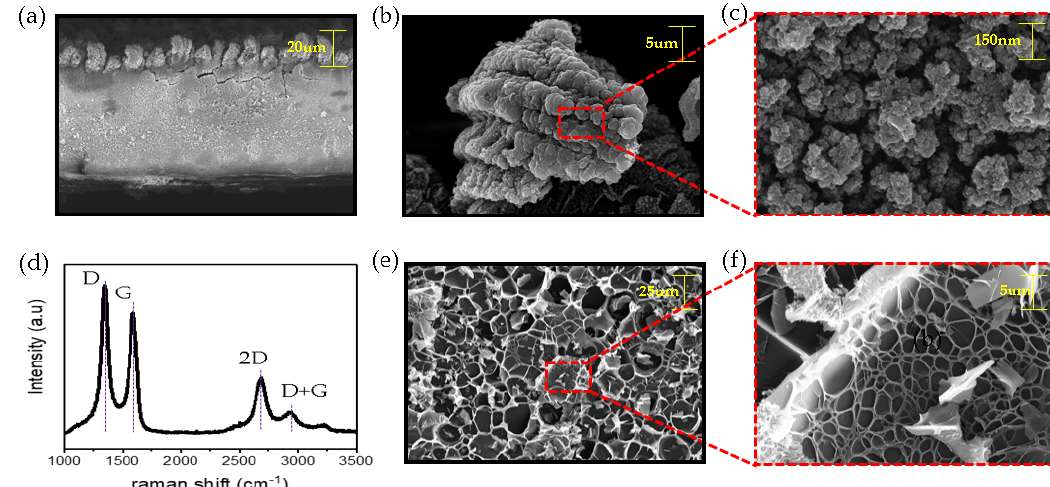
Figure 5. Three-dimensional porous structures of graphene (3D-PGS) properties of hair-like LIG patterns: ( a ) cross-section FE-SEM image, ( b , c ) FE-SEM images of hair-like LIG patterns, ( d ) Raman spectra of LIG patterns in the range 1000–3500 cm − 1 , ( e , f ) FE-SEM images inside hair-like LIG patterns.